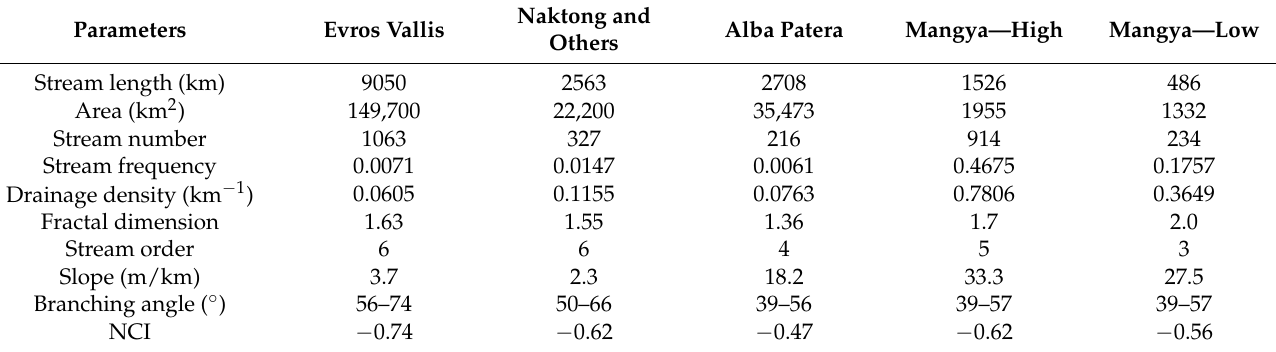
Table 3. The morphometric parameters of valley networks on Mars and the Qaidam Basin. Mangya—high and Mangya—low represent the parameters extracted from elevation data with a horizontal resolution of 30 m and 463 m, respectively. Naktong and Parameters Evros Vallis Alba Patera Mangya—High Mangya—Low Others